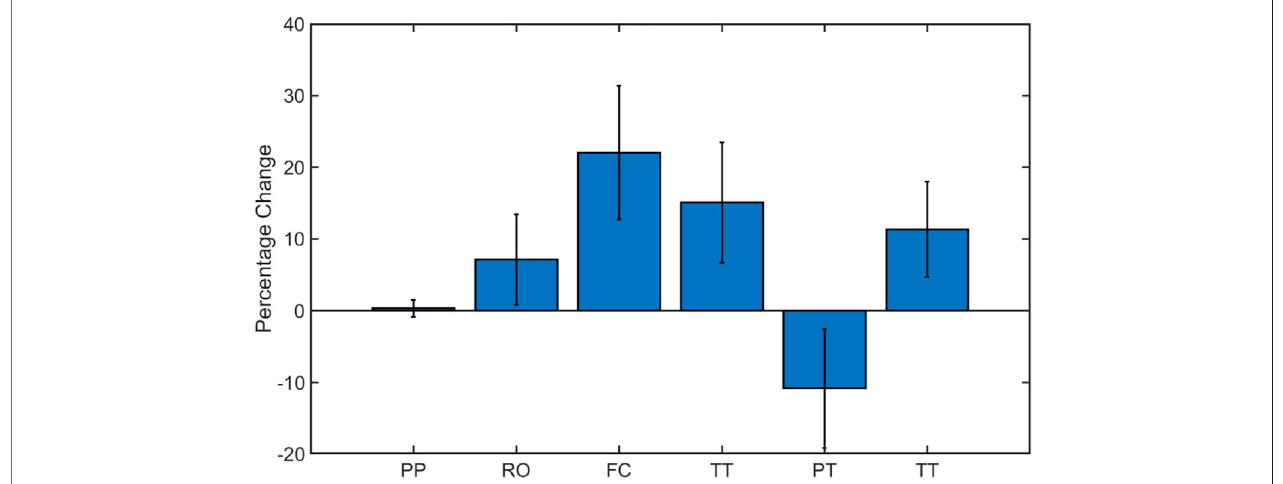
FIGURE 6 | Percentage change in manipulation time with gloves on for the various task category: Pick and Place (PP), Reorientation (RO), Fine Component Manipulation (FC), Tool Task (TT), Puzzle Task (PT) and Total Time (TT).